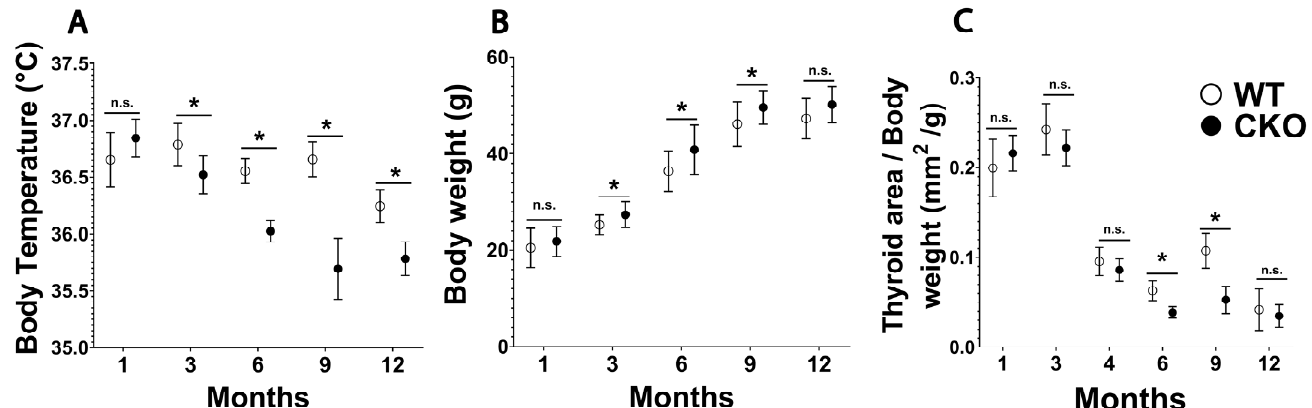
Figure 1. Physiological parameters of W.T. and CKO male mice at different ages. ( A ) Significant changes in CKO body temperature compared to W.T. at 3 months old [t (12) = 2.62, p = 0.022], 6 months old [t (48) = 3.51, p < 0.005], 9 months old [t (28) = 2.82, p < 0.005], and 12 months old [t (28), p = 0.032]. ( B ) Significant changes in CKO body weight compared to W.T. at 3 months old [t (10) = 2.23, p = 0.049], 6 months old [t (48) = 3.2, p < 0.005], and 9 months old [t (17) = 2.17, p = 0.042]. ( C ) Significant changes in CKO normalized thyroid area compared to W.T. at 6 months old [t (8) = 2.41, p = 0.042] and 9 months old [t (11) = 2.26, p = 0.045]. * p < 0.05 considered significant, CKO vs. W.T. male mice. n.s. (nonsignificant). Values are means ± S.E.; n = 7–9 mice/group. t -test was performed to compare CKO and W.T. male mice at 1, 3, 6, 9, and 12 months old. Repeated measures ANOVA as performed to monitor changes in body temperature, body weight, and the normalized thyroid area at different ages for each